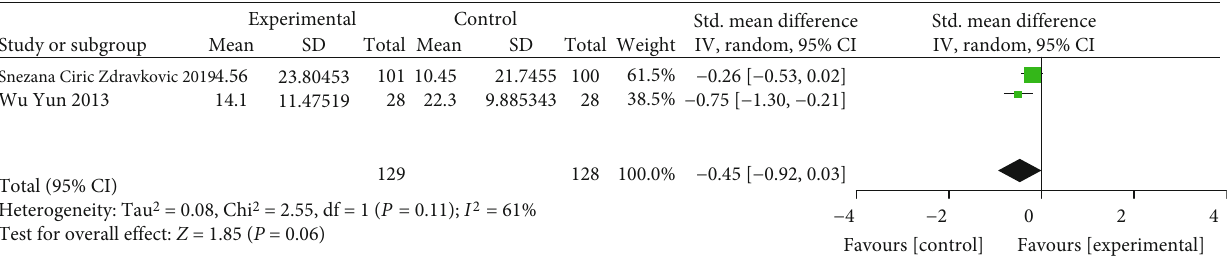
Figure 9: Forest plots of the e ff ect of oral iron on